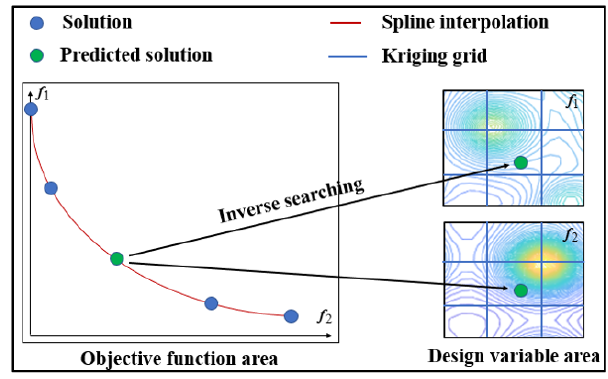
Figure 2. Conceptual diagram of Inverse searching.